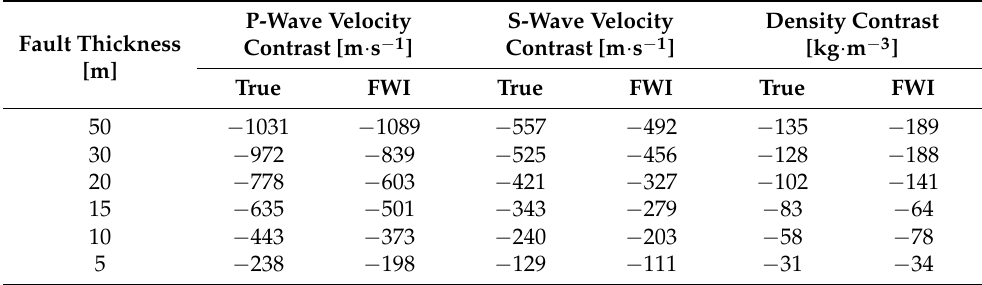
Table 2. The recovered contrast according to the maximum true contrasts, where True means the physical parameter contrast for the fault in the reference or True model and FWI means the physical parameter contrast for the fault in the models estimated by the FWI. Note that these contrasts are relative to the background values.